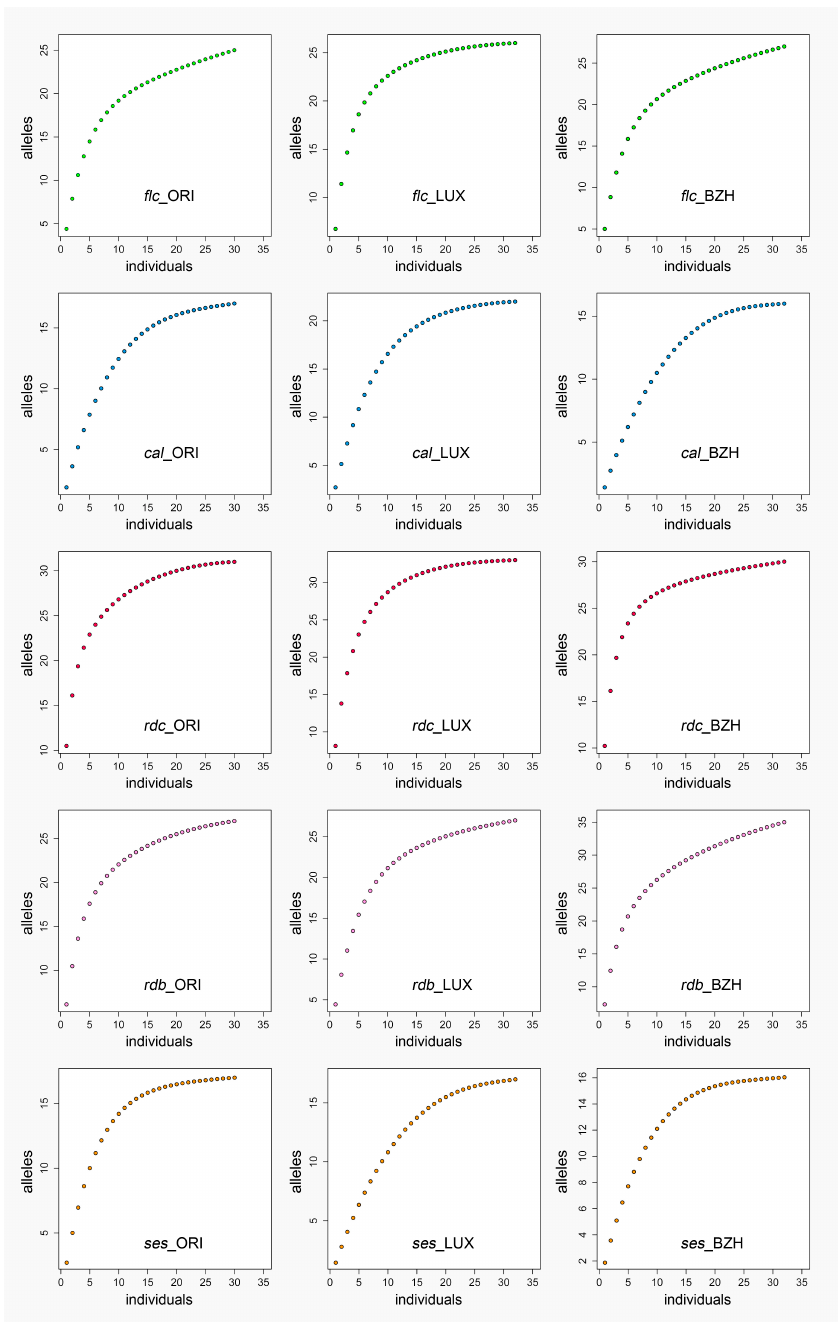
Figure 1. Mean SSR allelic richness accumulation curves of studied populations. Populations are coded according to Table 1. according to Table